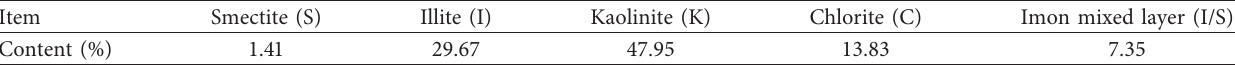
Table 6: Clay minerals from one well in SASP.